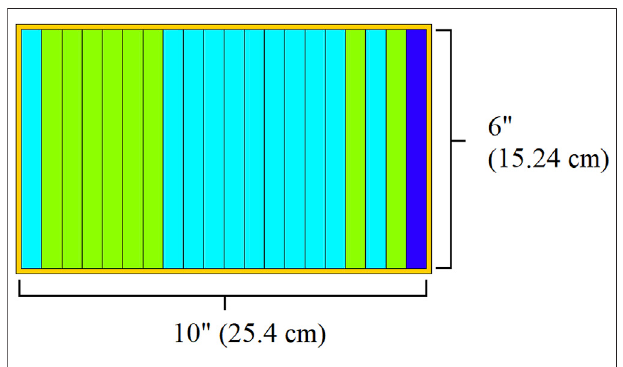
FIGURE 1 | Fast neutron source single cassette MCNP